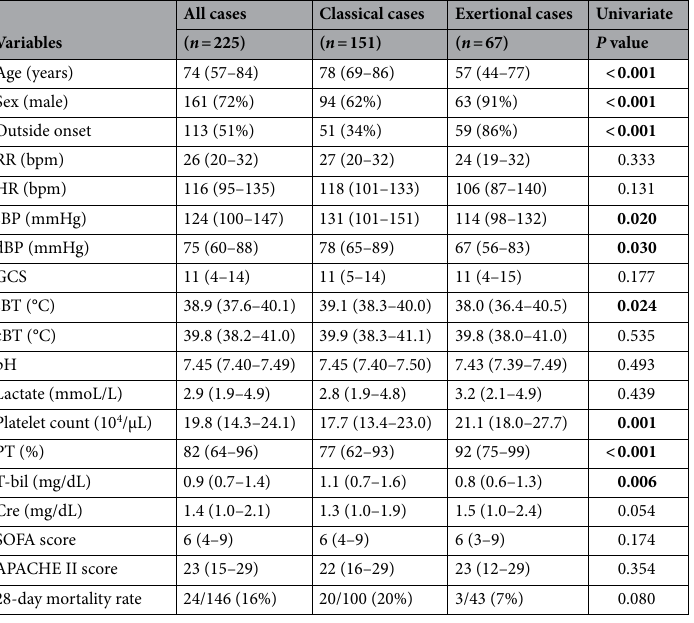
Table 1. Characteristics of patients with heatstroke on admission. Values are median (interquartile range) or n (%) of patients. P value: classical cases v.s. exertional cases. RR respiratory rate; HR heart rate; sBP systolic blood pressure; dBP diastolic blood pressure; GCS Glasgow Coma Scale; sBT surface body temperature; cBT core body temperature; PT prothrombin time; T-bil total bilirubin; Cre creatinine; SOFA Sequential Organ Failure Assessment; APACHE Acute Physiology and Chronic Health Evaluation. Significant values are in bold.